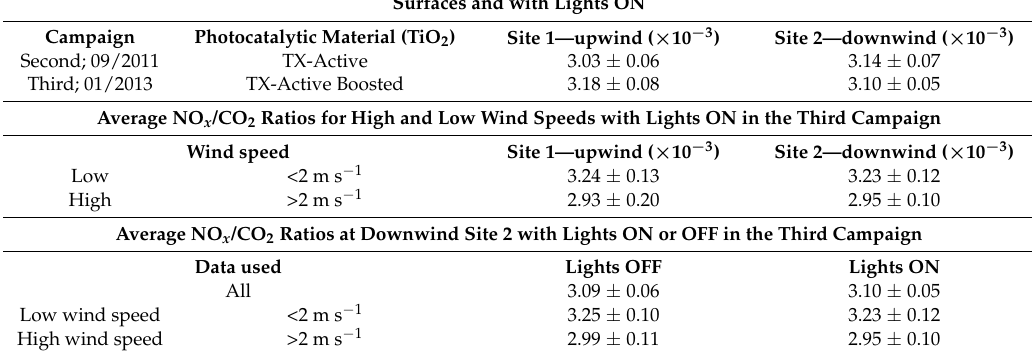
Table 9. Average NO x /CO 2 ratios obtained from experimental results in the photocatalytic remediation of NO x in the Leopold II tunnel in Brussels; standard errors represent 2 σ